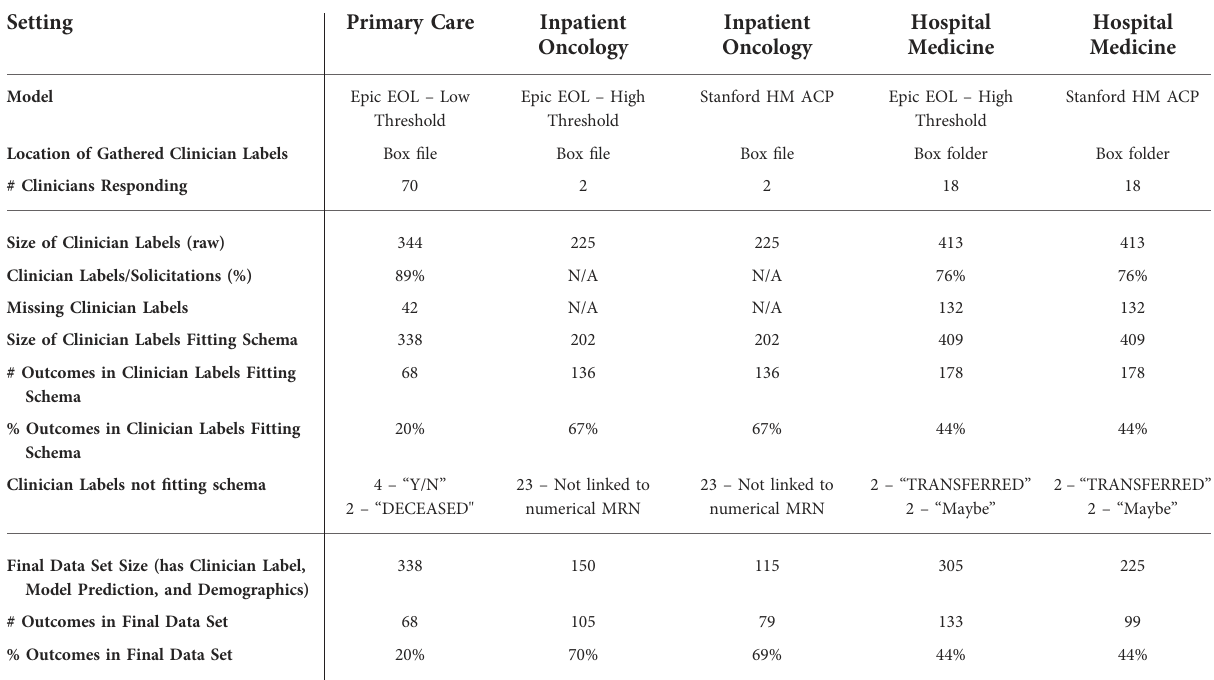
TABLE 4 Processing and fi nal data